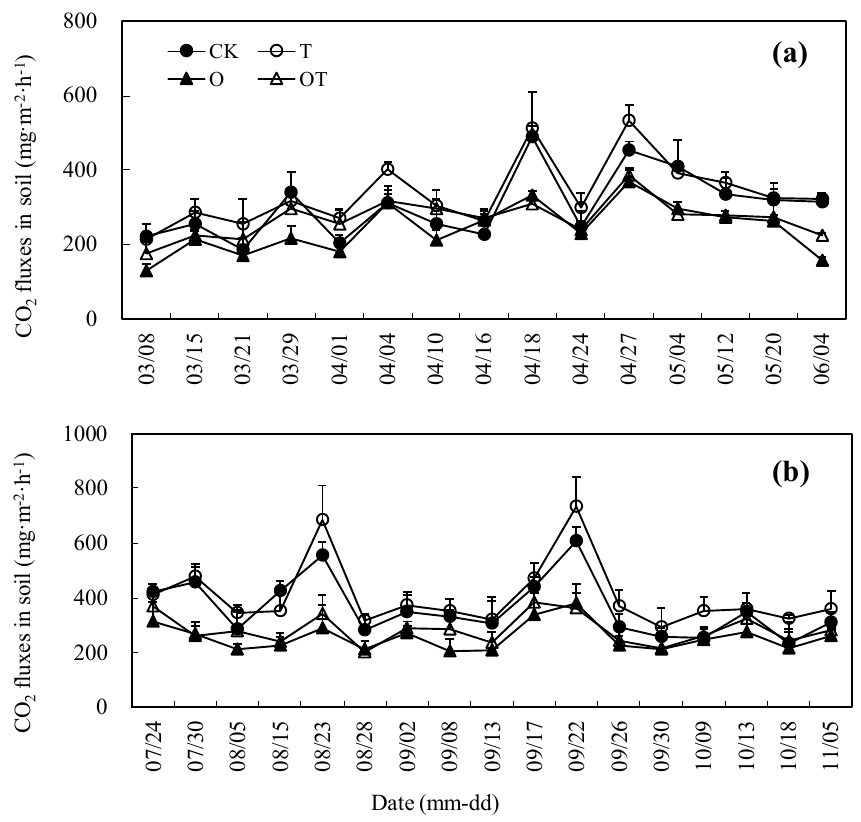
Figure 3. Effect of warming and elevated O 3 concentration on CO 2 emission fluxes from soil: ( a ), ( b ) Soil CO 2 emission fluxes in winter wheat and soybean-growing seasons, respectively. Data are the mean values. Error bars are SEs. In figure ( a ), date 03-08 to 03-28 are the turning-green stage, 03-29 to 04-09 are the elongation-booting stage, 04-10 to 4-26 are the heading-flowering stage, and 04-27 to 06-04 are the grain filling-maturity stage of winter wheat. In figure ( b ), date 07-24 to 08-14 are the branching stage, 08-15 to 09-21 are the flowering-pod stage, and 09-22 to 11-05 are the grain filling-maturity stage of soybean.